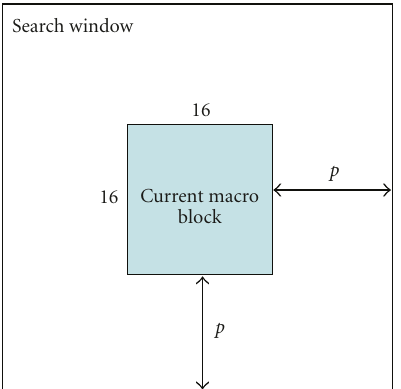
Figure 2: Block Matching a macroblock of side 16 pixels and a search parameter p of size 3